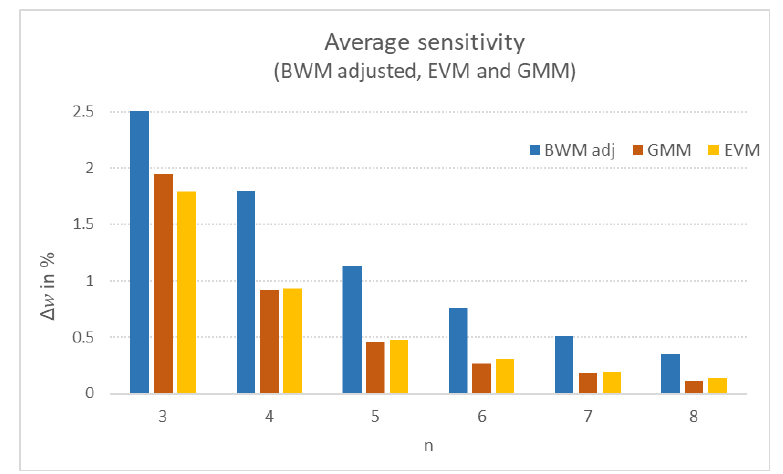
Figure 2. Mean sensitivity: BWM, EVM, and GMM.